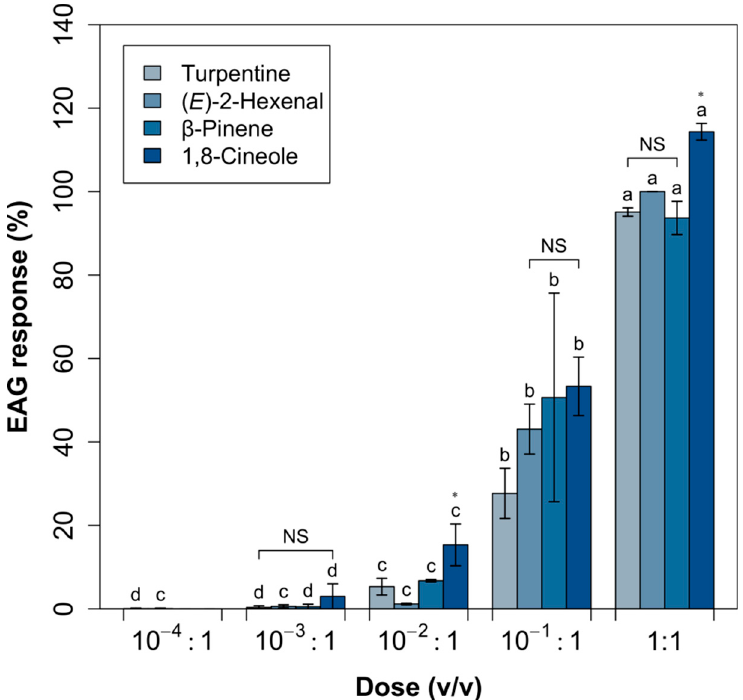
Figure 2. Dose-response EAG profiles (Mean 0.2 ± Error 0.2 ) of Cerambyx welensii females. Responses are expressed as normalized percentages relative to the standard stimulus ( E )-2-hexenal. For each odorant, letters on the columns denote differences between doses. Differences between odorants at each dose are indicated by an asterisk (NS indicates no significant differences) (Heteroscedastic ANOVA for related samples, n = 5).